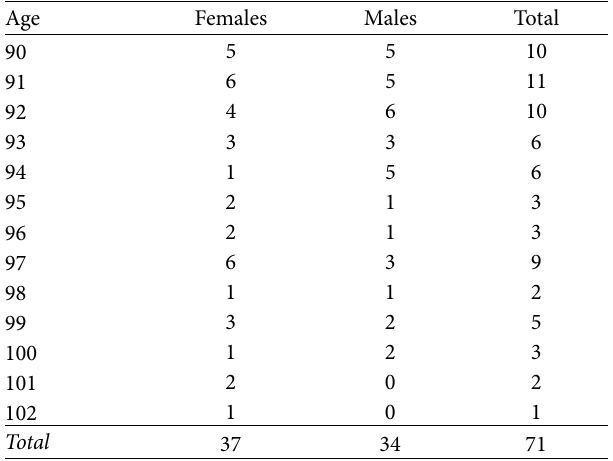
Table 1: Characteristics of the oldest olds included in the study according to age and